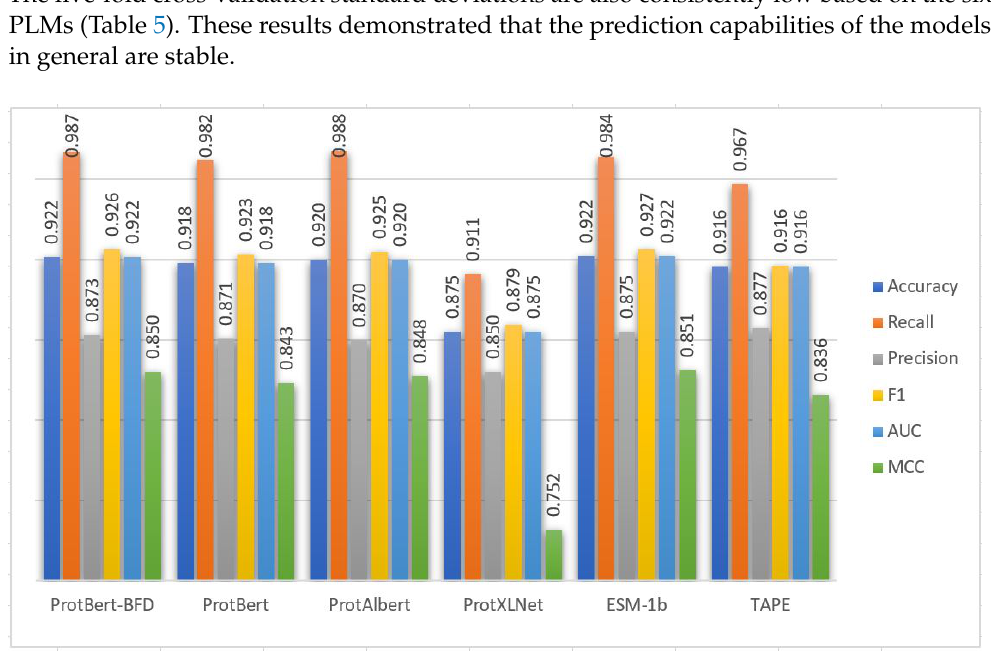
Figure 3. Cross-validation performance results of PTG-PLM on the Ngly training dataset based on the six PLMs. Table 5. Cross-validation performance results of CNN model based on the six PLMs on the Ngly dataset. The results of the five-fold cross-validation on the training dataset are represented by the average ± standard deviation for all performance